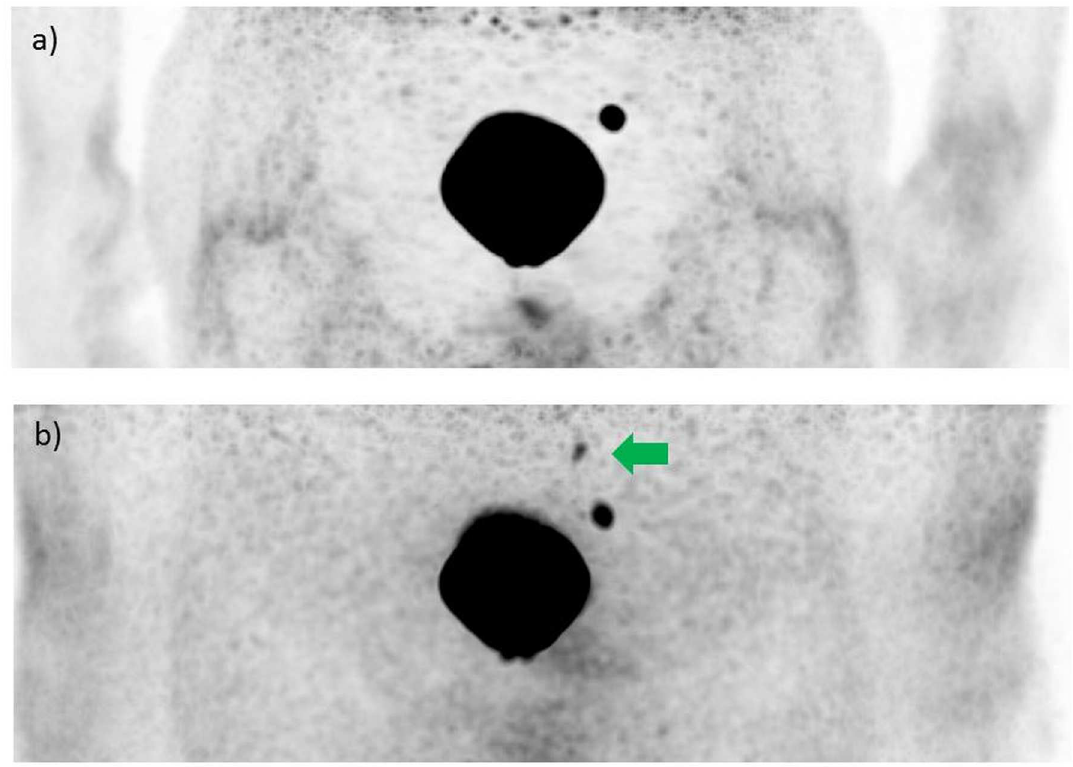
Fig 2. PET images of a patient (age: 66 years, serum PSA: 2.3 ng/ml) with recurrent PCa in two iliacal lymph nodes obtained with the PET/MR hybrid imaging system at 134 min after intravenous injection of 68 Ga-HBED-CC-PSMA (146 MBq). a) Scatter und attenuation corrected PET images with intense ‘halo artifact’ showingonly one iliacal lymph node. b) Non-scatter and attenuationcorrected PET image showingboth lymph nodes that were seen on PET/CT as